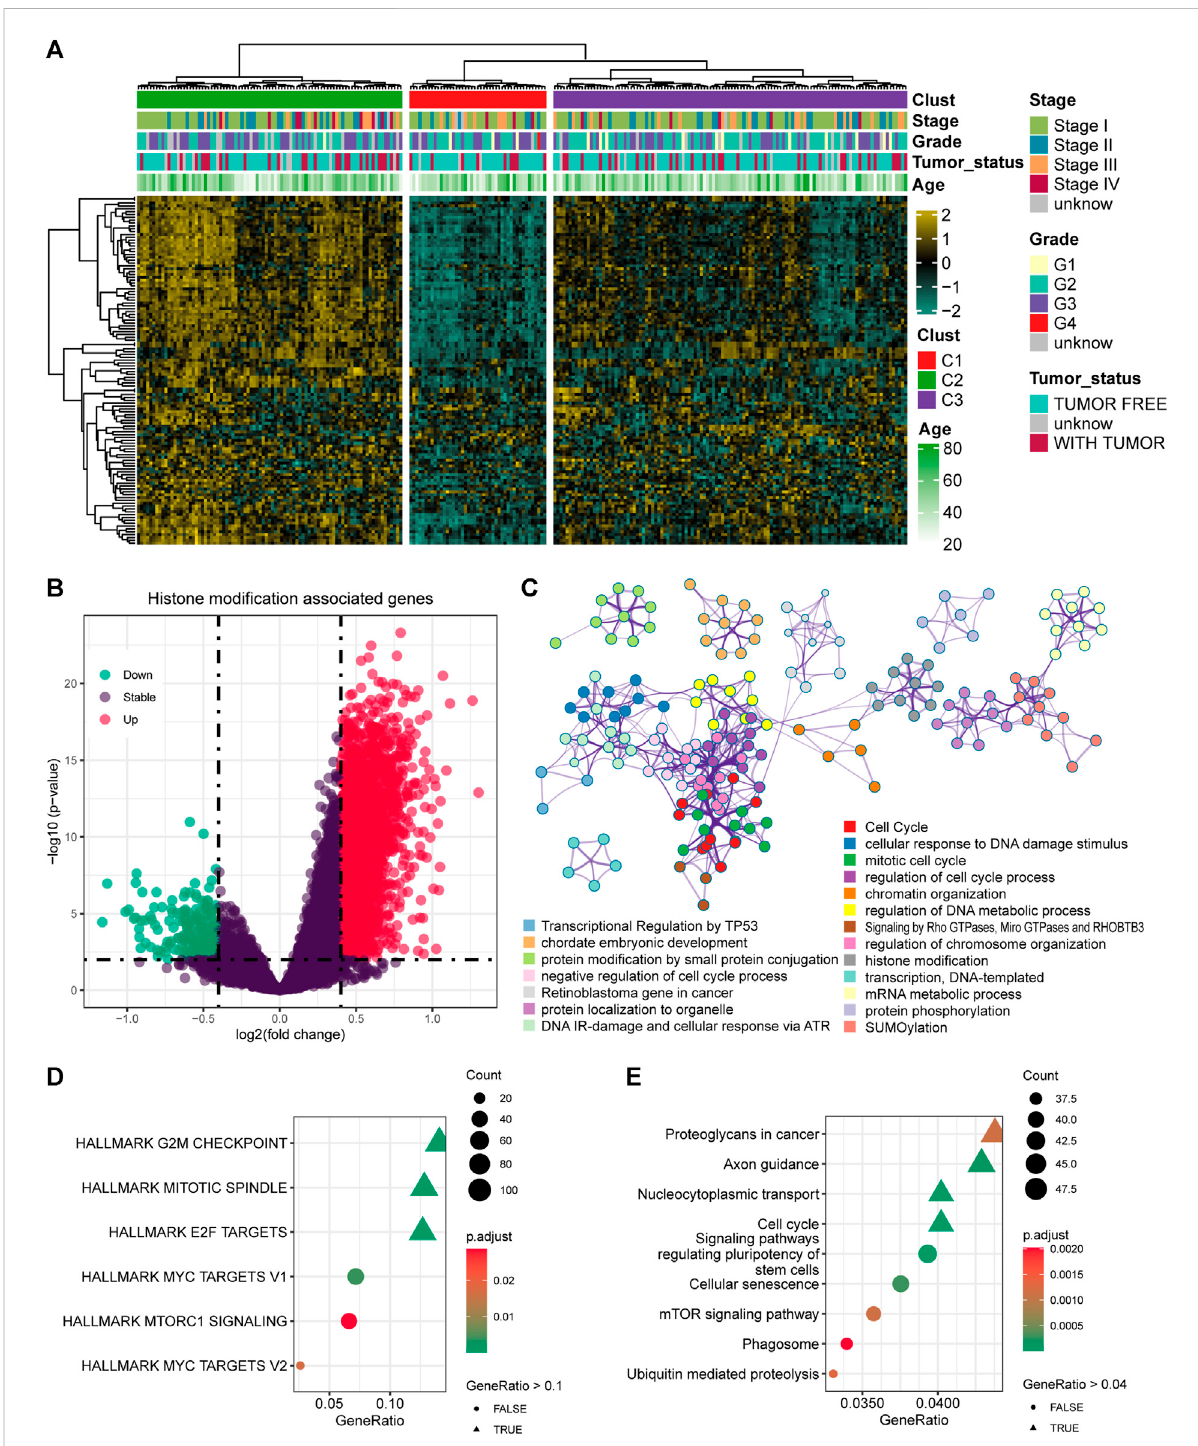
FIGURE 1 Identi fi cation of the histone modi fi cation-altered genes and pathways. (A) Heatmap showing the activation status and clinical features in cervical cancer patients. (B) Differentially expressed genes (DEGs) between the histone modi fi cation-activated and -suppressed subgroups. (C) Enriched signaling pathways of the DEGs using Metascape. (D) Enriched signaling pathways of the DEGs by HALLMARK pathways. (E) Enriched signaling pathways of the DEGs by KEGG